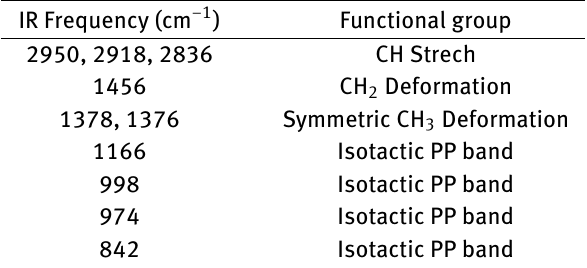
Table 6: FTIR absorption bands and identifications for polypropy- lene reference